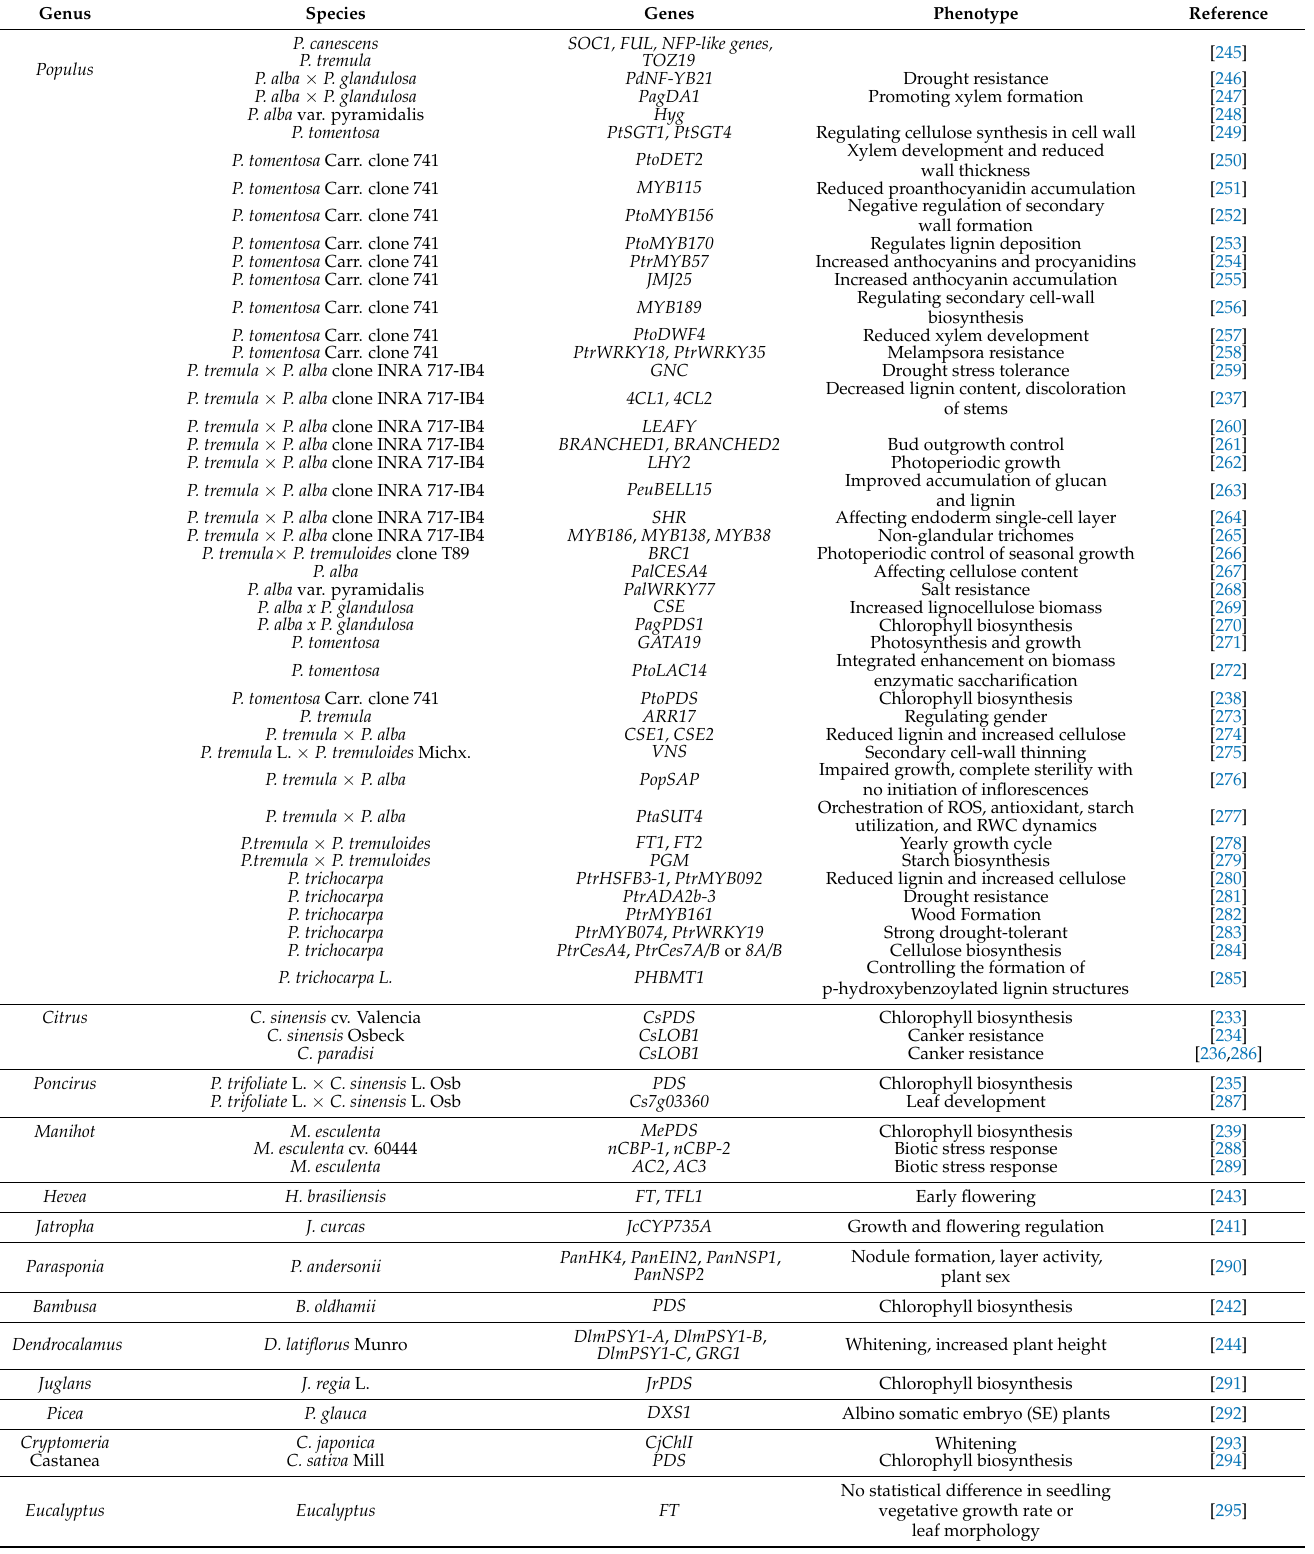
Table 2. Application of CRISPR/Cas system in woody